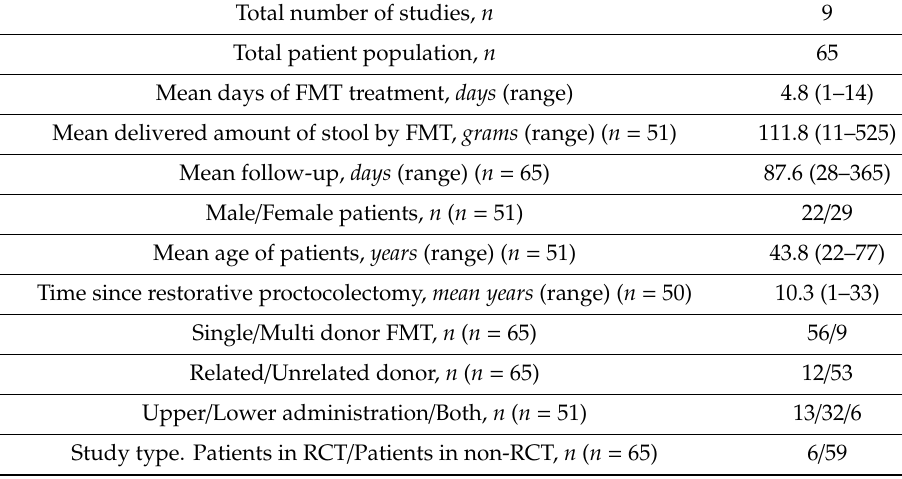
Table 1. Patient characteristics, preparation of FMT and di ff erent treatment approaches of patients treated with FMT for chronic